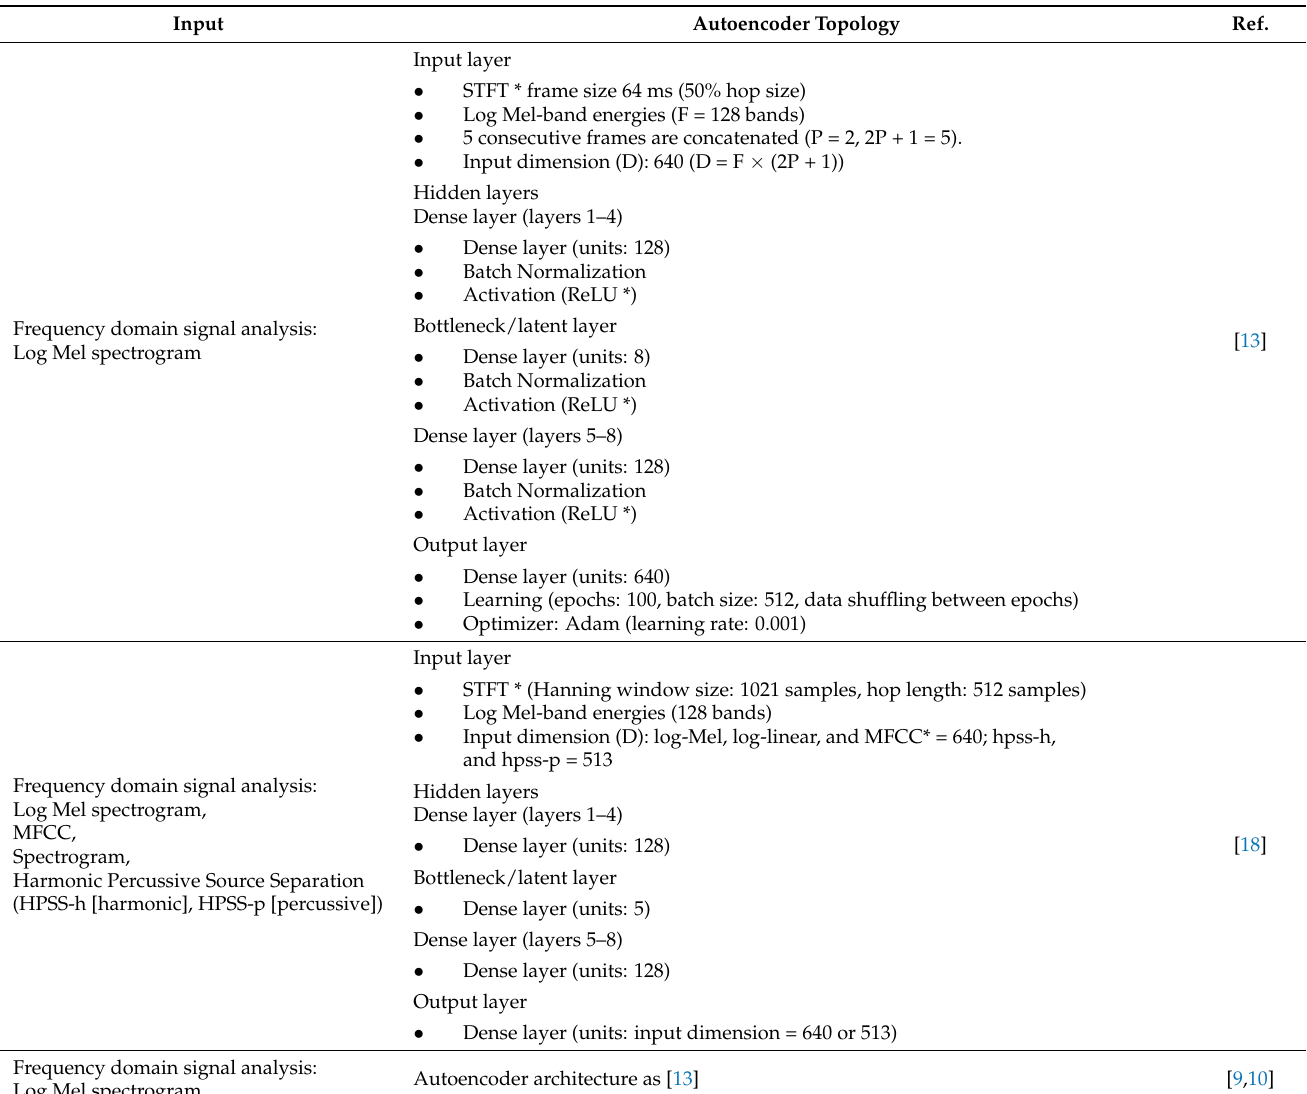
Table 1. Baseline auto encoder system architecture for anomaly